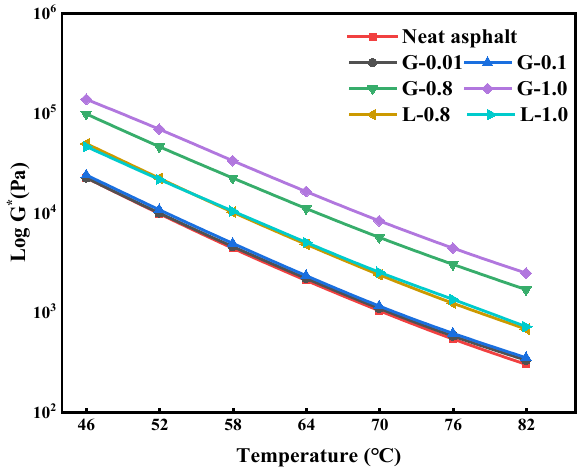
Figure 2. Dynamic shear moduli of asphalts and mastics.